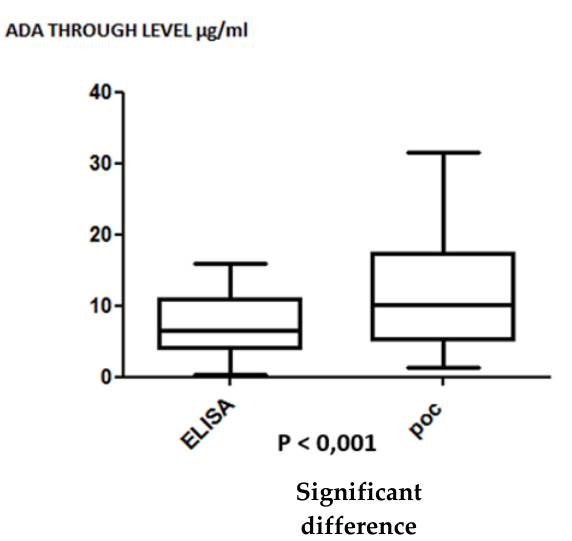
Figure 4. Comparison of adalimumab trough levels in the prospective IBD cohort between ELISA (Theradiag) and POC assay (Quantum Blue; Bulhman).